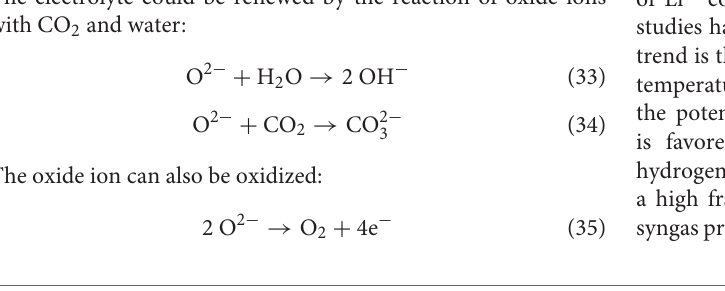
TABLE 2 | Some syngas and methane generation results (Wu et al., 2016; Liu et al., 2017; Li et al., 2018; Ji et al., 2019).